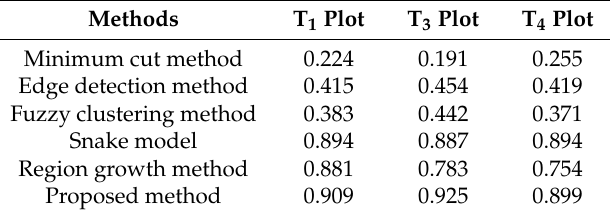
Table 6. Uniform measurement values of regions for different segmentation methods.